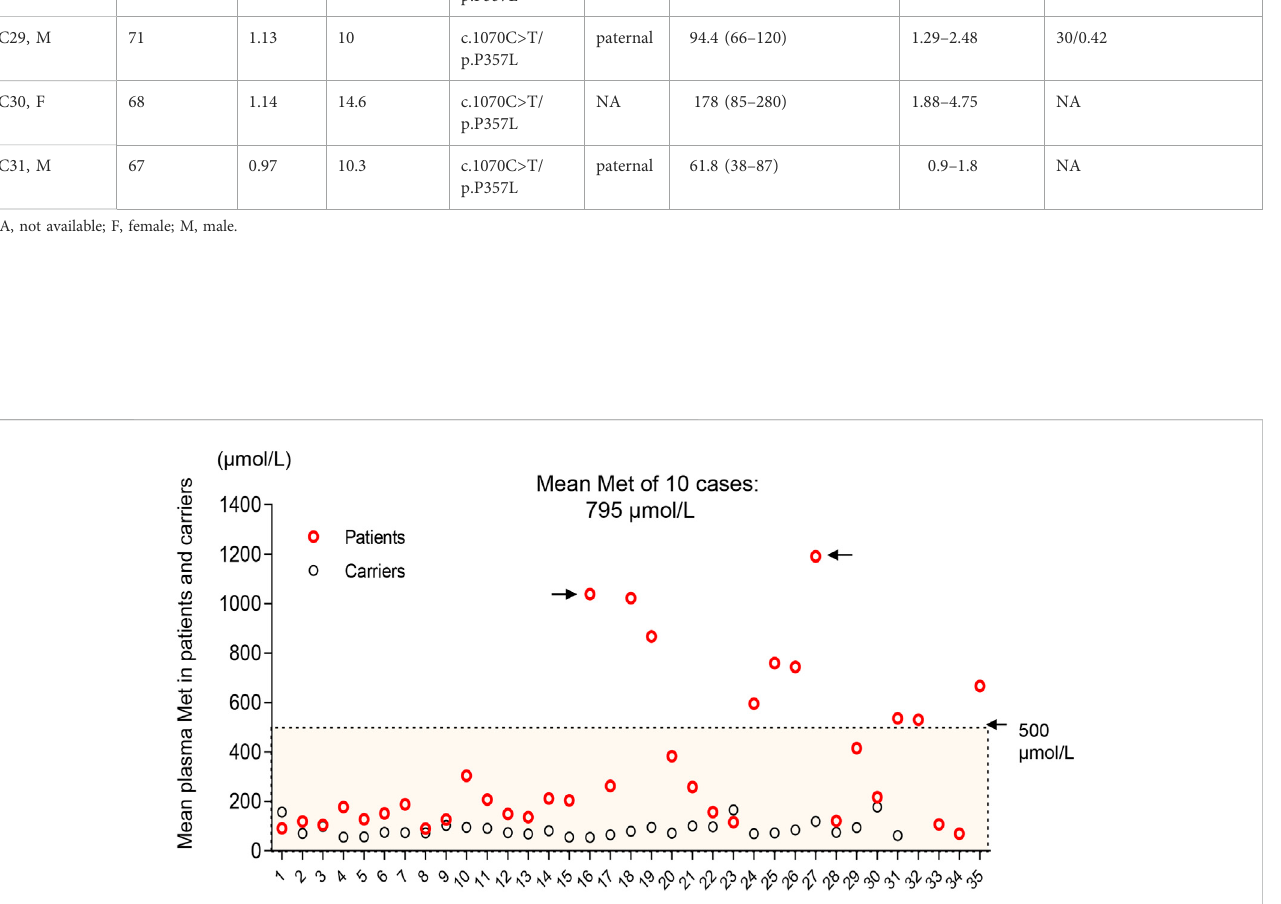
FIGURE 4 Distribution of mean plasma Met values inthe fi rst 4 months of lifein patients (red) and carriers (black).Ten patients with interventions deviated from the other 25 cases with a mean Met > 500 μ mol/L. Black arrows indicate patients (P16 and P27) with white matter lesions.